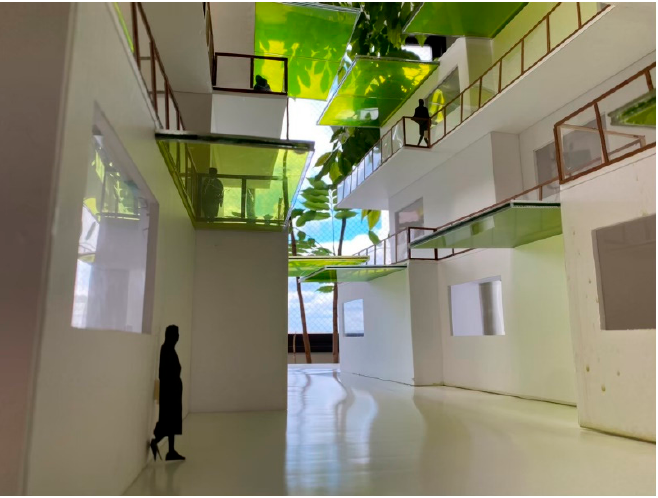
Figure 1. Photosynthetic architectural model [24].